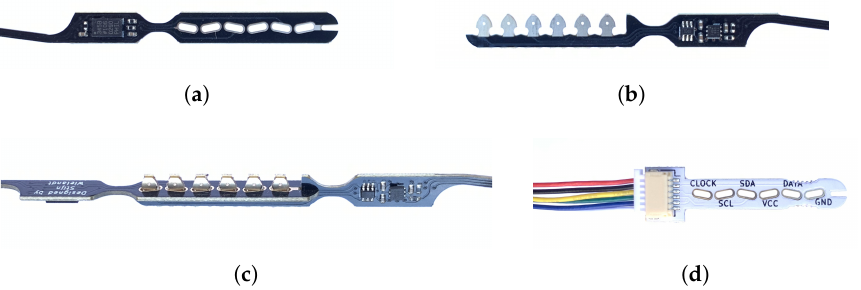
Figure 3. Close-ups of the proposed connector technology. ( a ) Female connector piece; ( b ) Male connector piece; ( c ) Mated connector; ( d ) Wire-to-Board